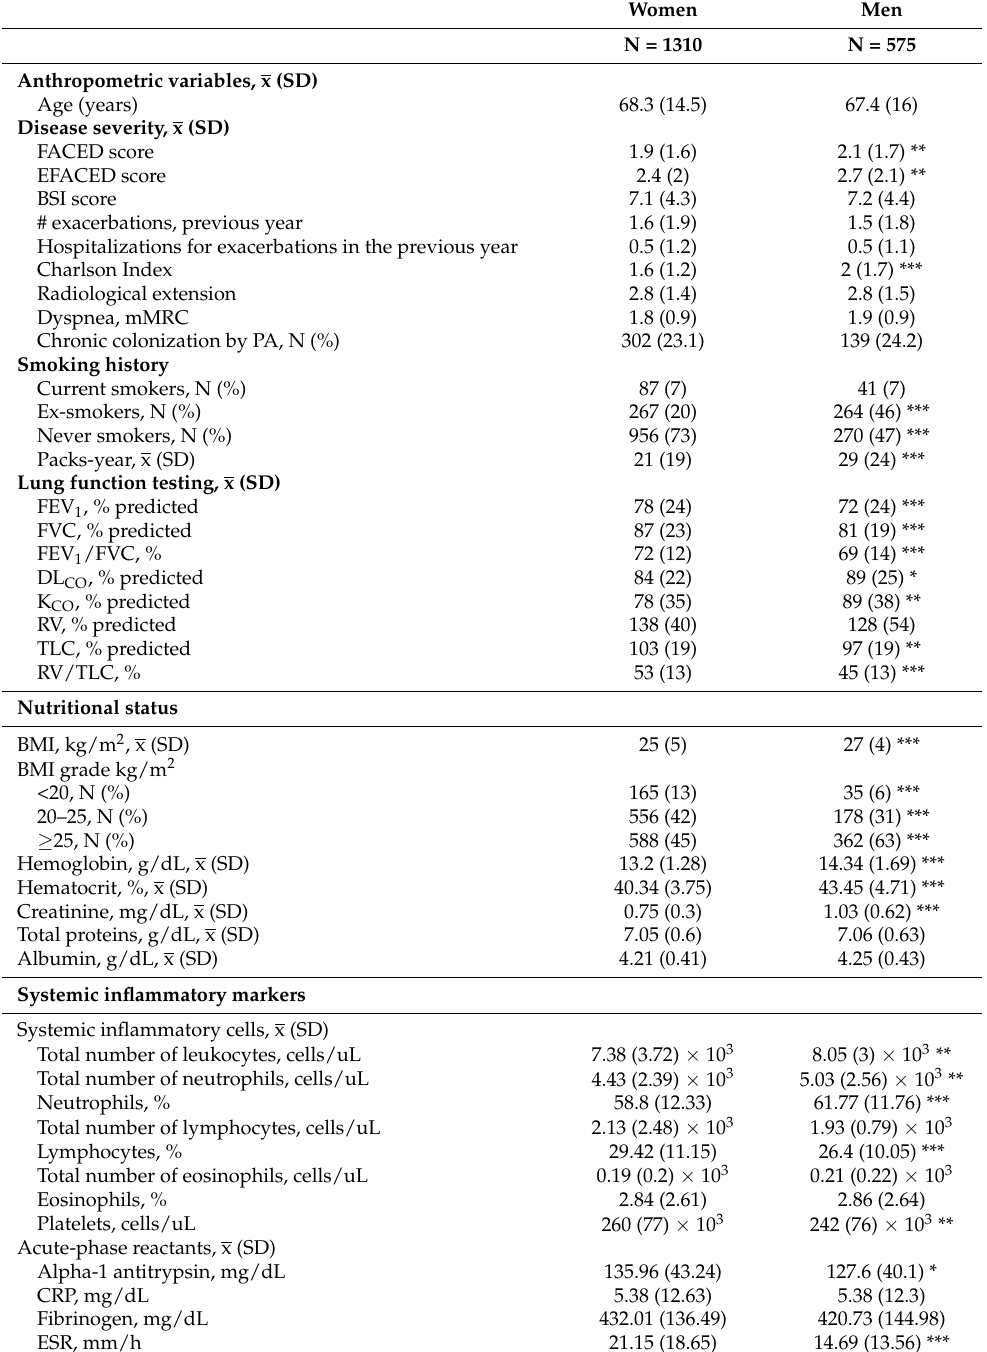
Table 2. Clinical parameters and nutritional and inflammatory status of bronchiectasis patients excluding those with COPD: females and